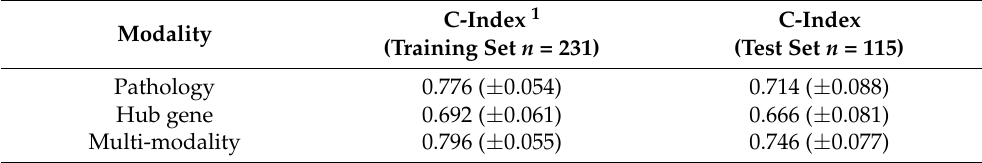
Table 2. Concordance index (C-index) of single-modality and multi-modality models.